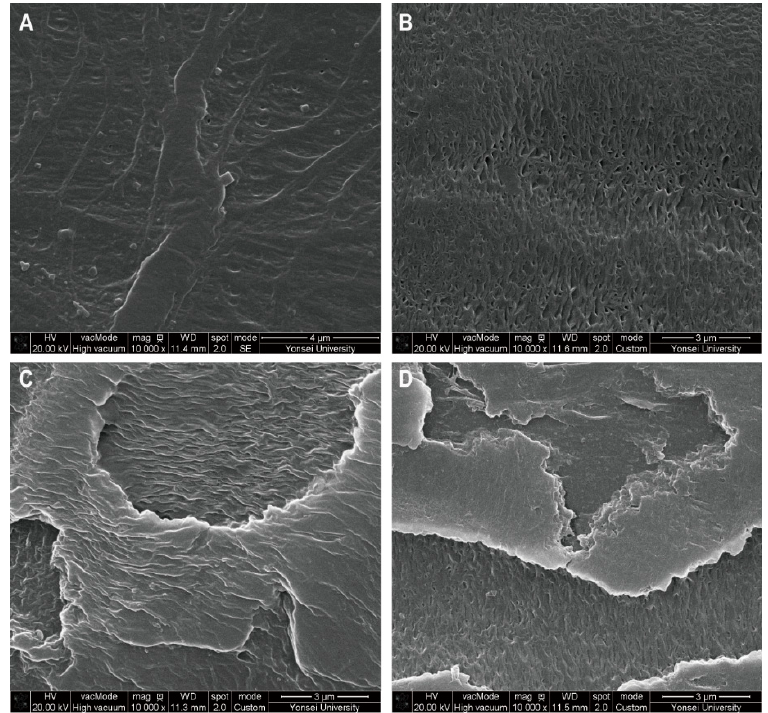
Figure 4. SEM micrographs of control and treated HDPE samples at 10,000 × magnification. ( A ) Control, ( B ) malt extract medium (ME), ( C ) liquid medium (LM), and ( D ) solid-state fermentation (SSF).